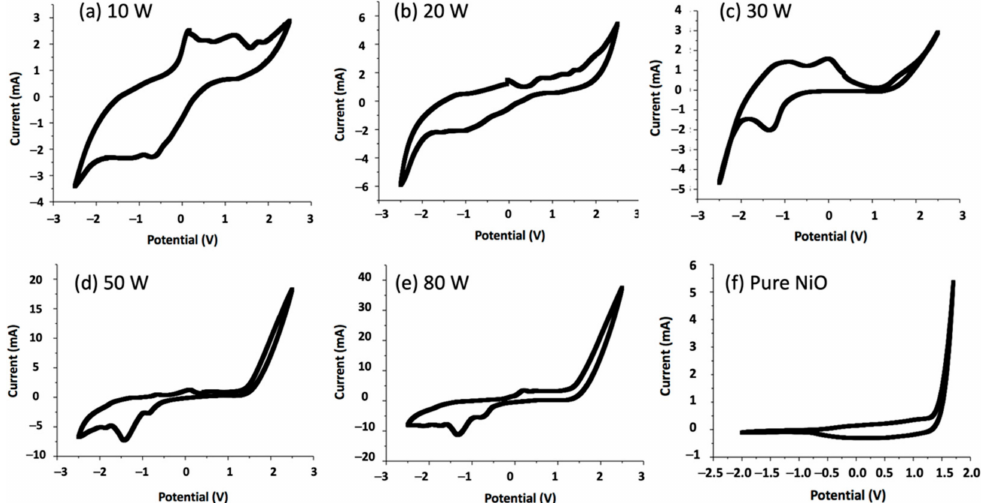
Figure 6. Cyclic voltammetry of the Ni-V-O thin films as ion storage layer of electrochromic device with various powers toward the Ni target, ( a ) 10 W, ( b ) 20 W, ( c ) 30 W, ( d ) 50 W, ( e ) 80 W, and ( f ) pure NiO,